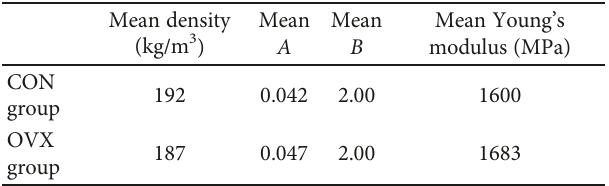
Figure 9: Results of mechanical bone properties. (a) Ultimate load, (b) experimental sti ff ness, (c) yield load, and (d) yield displacement for CON and OVX groups. Table 2: Comparison of Young ’ s modulus in the CON group and OVX group.